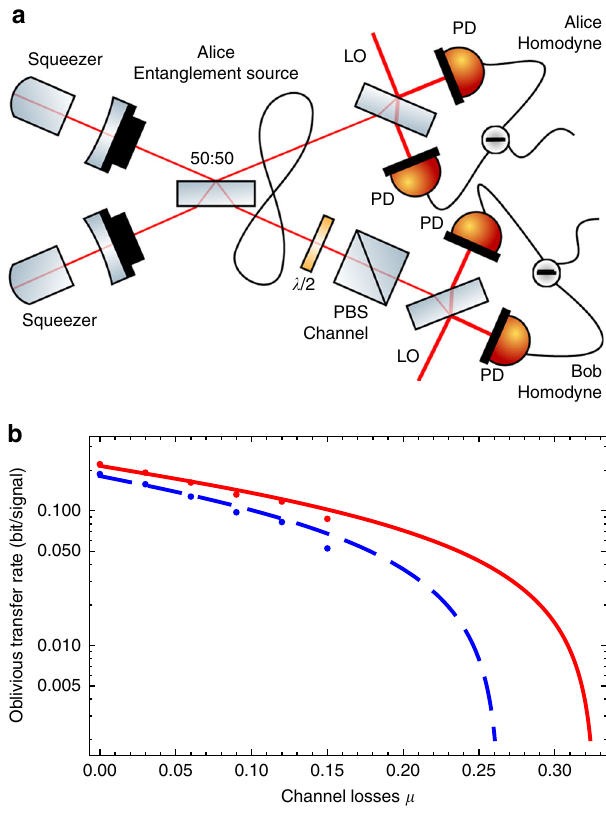
Fig. 3 Experimental setup and results. a Squeezed light at 1550 nm was generated in two parametric down-conversion sources and superimposed at a 50:50 beam splitter to obtain entanglement. One mode was kept locally by Alice and measured with homodyne detection randomly in the amplitude and phase quadrature. The other mode was sent through a free- space channel simulated by a half-waveplate and a polarizing beam splitter (PBS). Bob then performed homodyne detection randomly in amplitude and phase quadrature. PD photodiode, LO local oscillator. b Secure oblivious transfer rate per signal obtained in the experiment. Points correspond to the generated oblivious transfer rates in the experiment for two different storage rates, ν = 0.001 (red) and ν = 0.01 (blue), for quantum memories with a transmittance of 0.75. The lines show simulated oblivious transfer rates obtained by applying a one-sided loss channel with losses μ to the estimated two-mode squeezed state in the experiment. Parameters: n = in the encoding is assumed to be smaller than